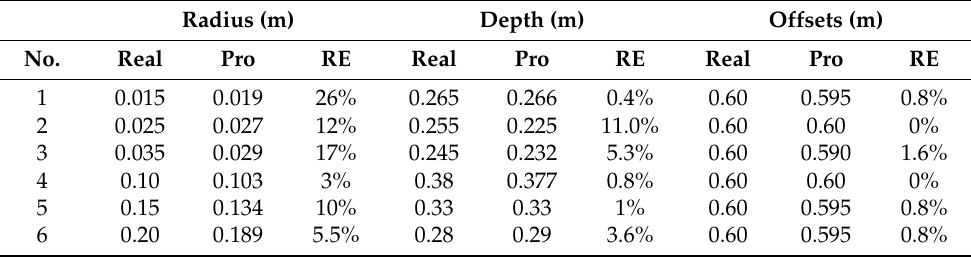
Table 2. Radius and location estimation of the single root.